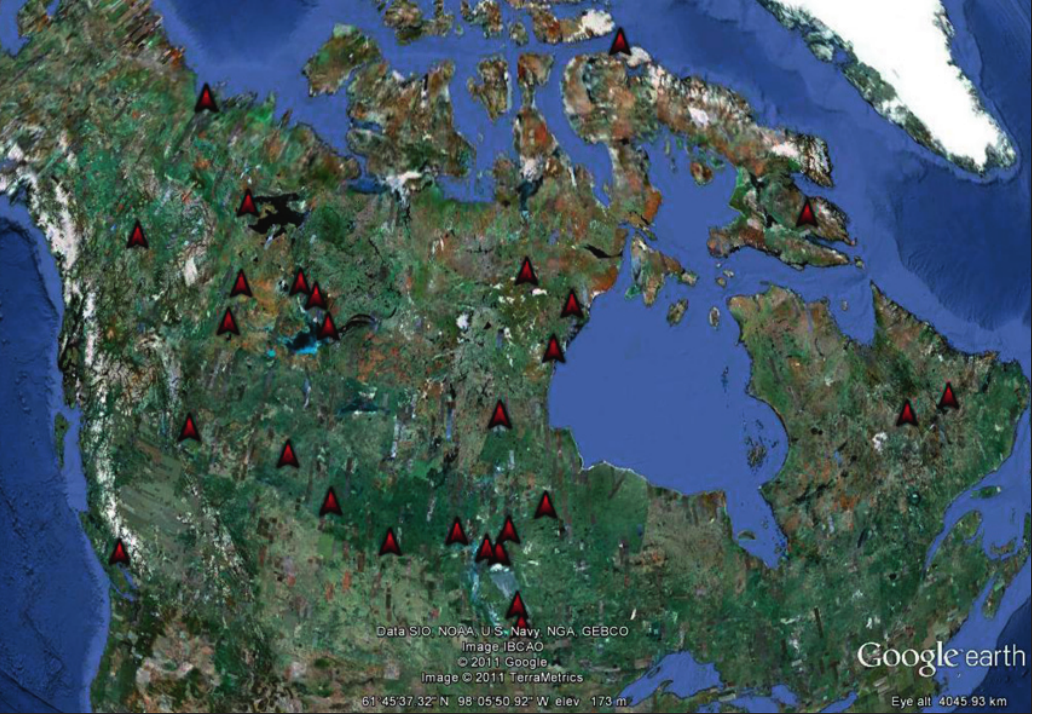
Fig. 1. This map, created during the Aboriginal Talking Circle, shows the geographical spread of the participating speakers across